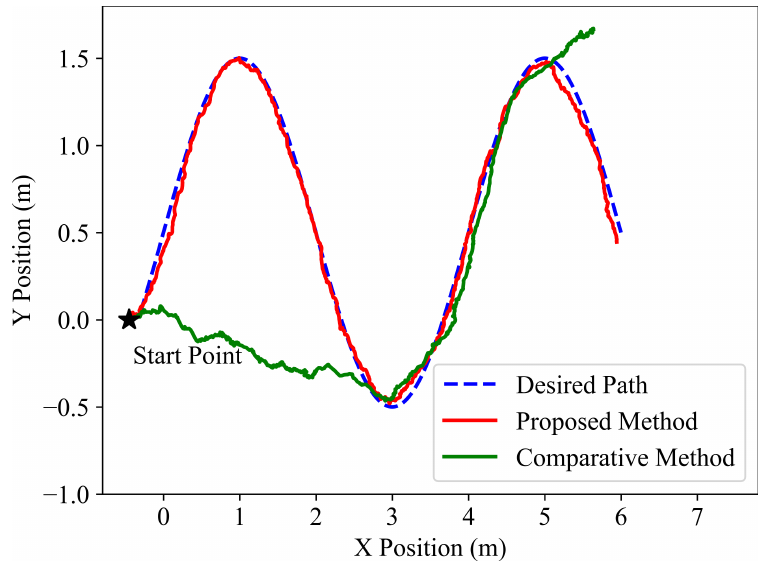
Figure 4. Simulation path following results of the desired sinusoidal curve for the proposed hierar- chical method and the end-to-end comparative method.